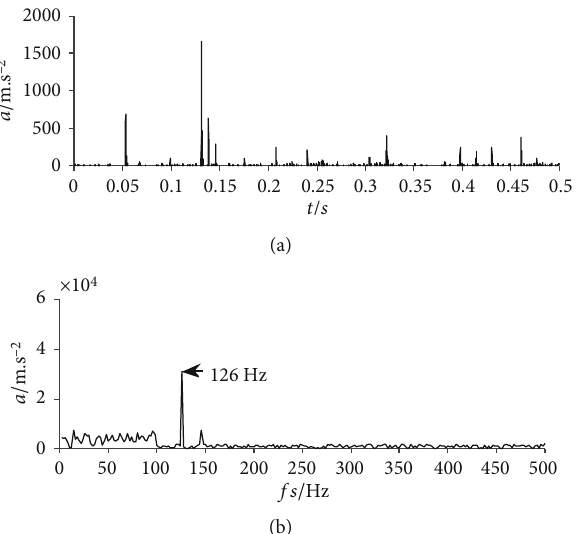
Figure 8: Waveform and frequency spectrum of bearing R outer ring defect signal denoised by a dual-tree complex wavelet. (a) Waveform. (b) Frequency spectrum.